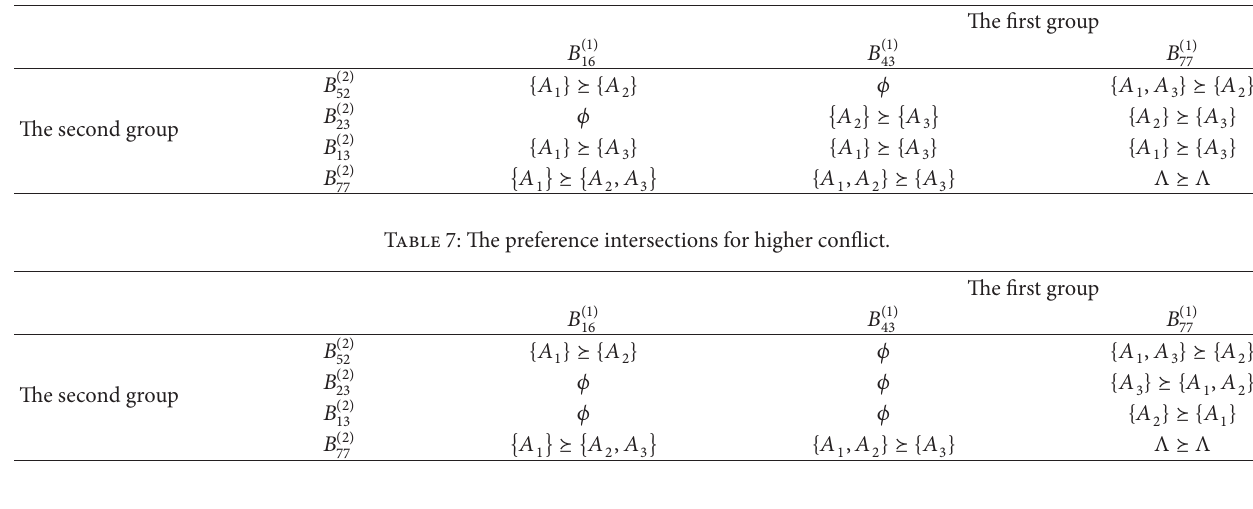
Table 6: The preference intersections for lower conflict.